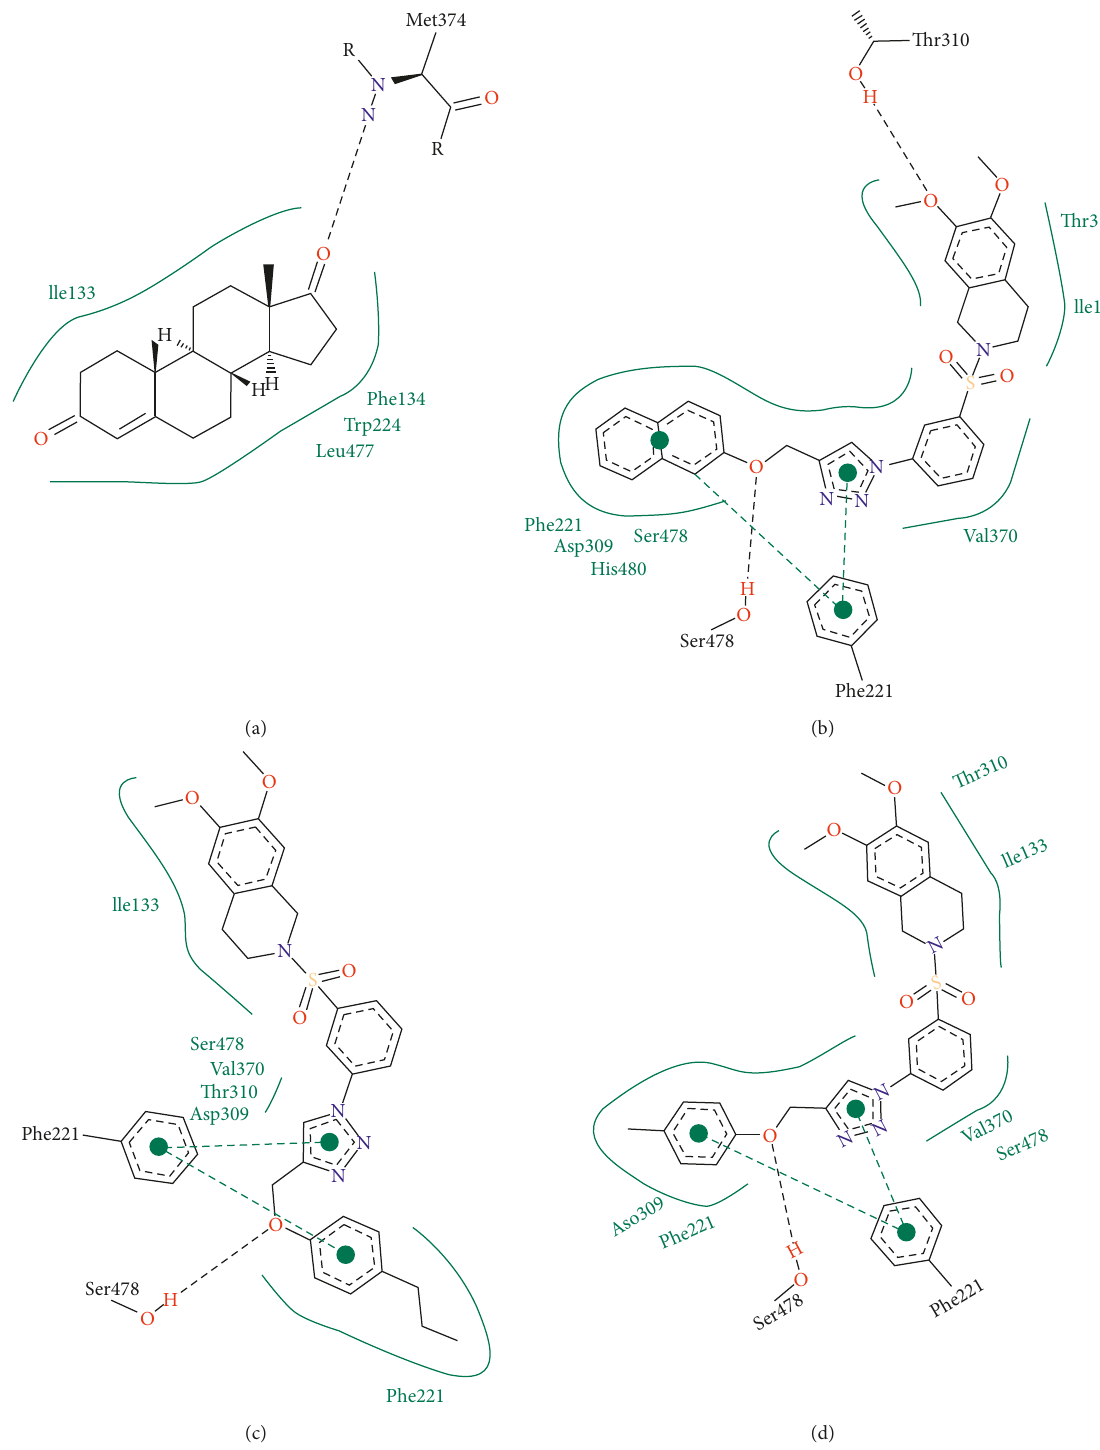
Figure 5: The 2D ligand protein interaction diagram. (a) Represents the 2D ligand-protein interactions of natural substrate ASD ∗ , (b) represents compound 2i, (c) represents compound 2d, and (d) represents compound 2b. Copyright 2019. Reproduced with permission from